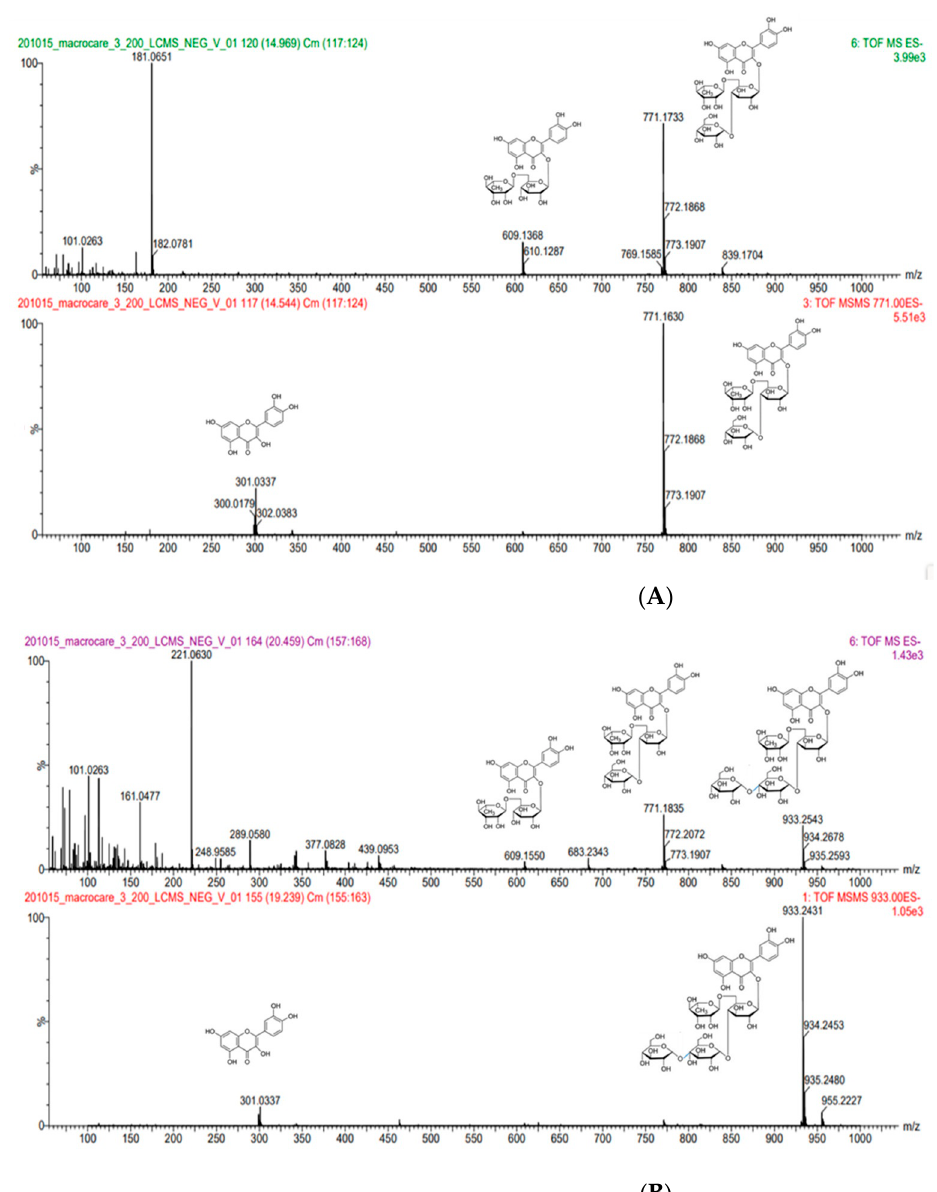
Figure 3. Spectra and fragmentation patterns of rutin mono-glucoside and rutin di-glucoside via LC-MS-MS analysis. ( A ) Mass spectra of rutin mono-glucoside, ( B ) mass spectra of rutin di-glucoside.